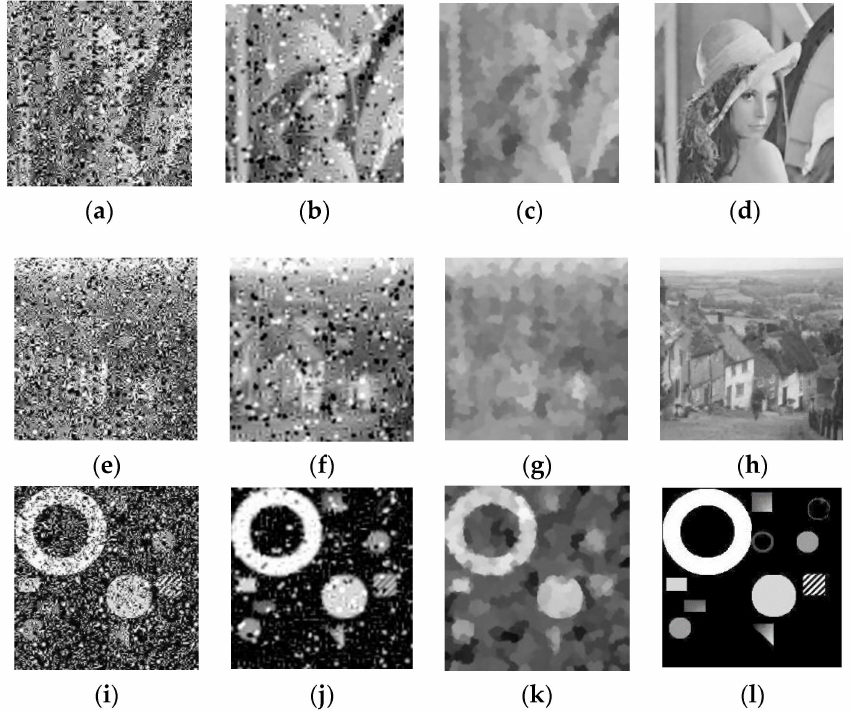
Figure 5. 5% wavelet coefficients are corrupted by salt-pepper noise and 10% coefficients are lost. ( a , e , i ) received images. ( b , f , j ) images reconstructed by TVL2 with λ = 10. ( c , g , k ) images reconstructed by TVL0 with λ = 3. ( d , h , l ) images reconstructed by TVL1.